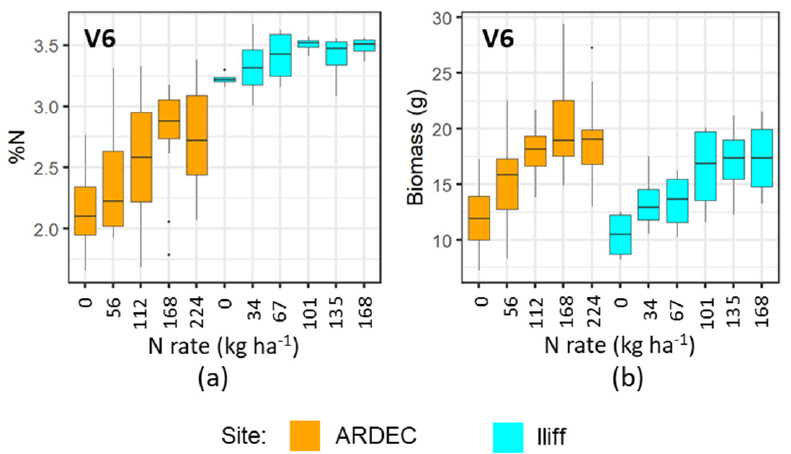
Figure 9. Variability of %N ( a ), and biomass ( b ) with different N rate applications at V6 growth stage of maize for two sites.